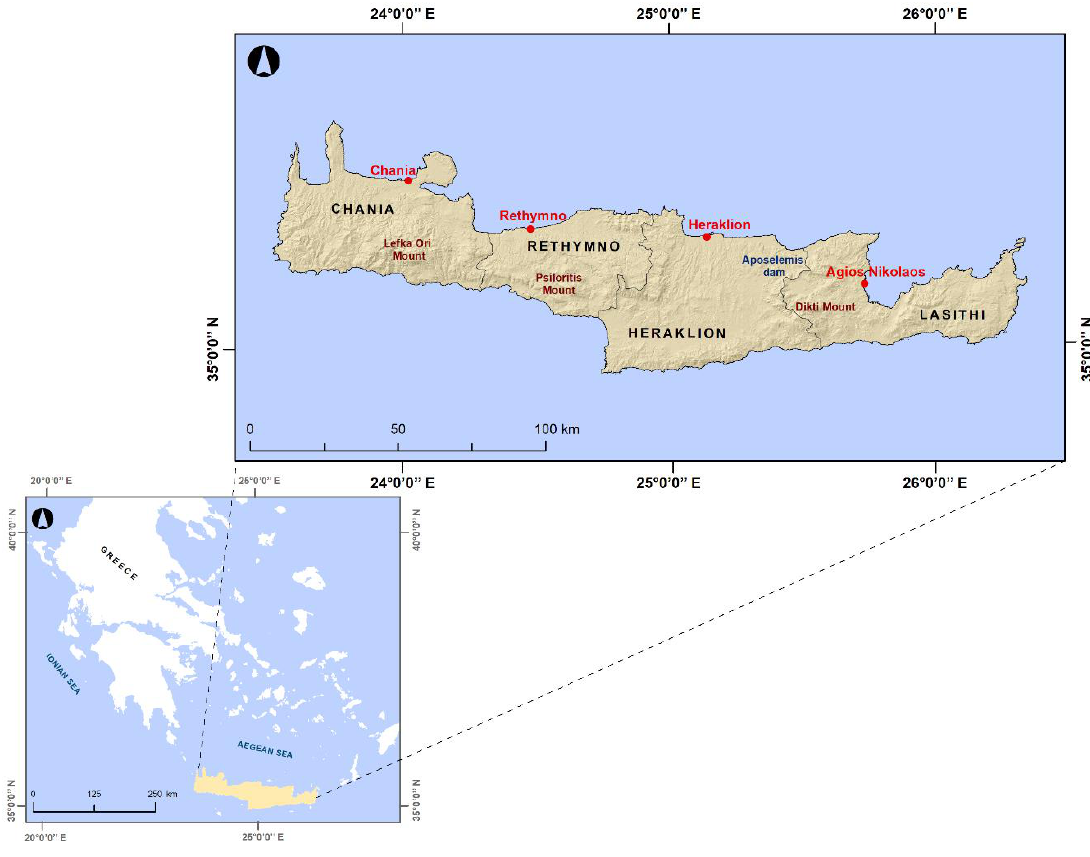
Figure 1. Study area and location maps.